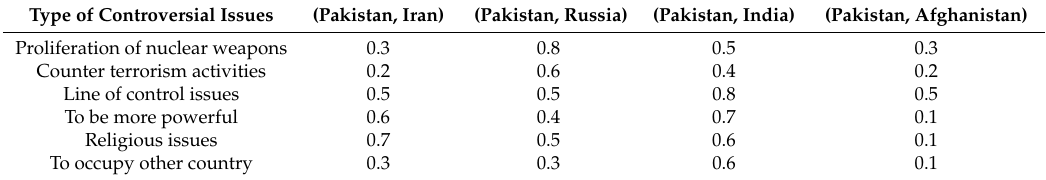
Table 6. Fuzzy set of controversial issues between Pakistan and other countries.